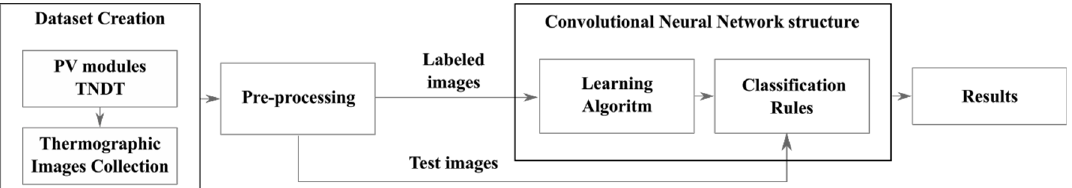
Figure 9. CNN construction.